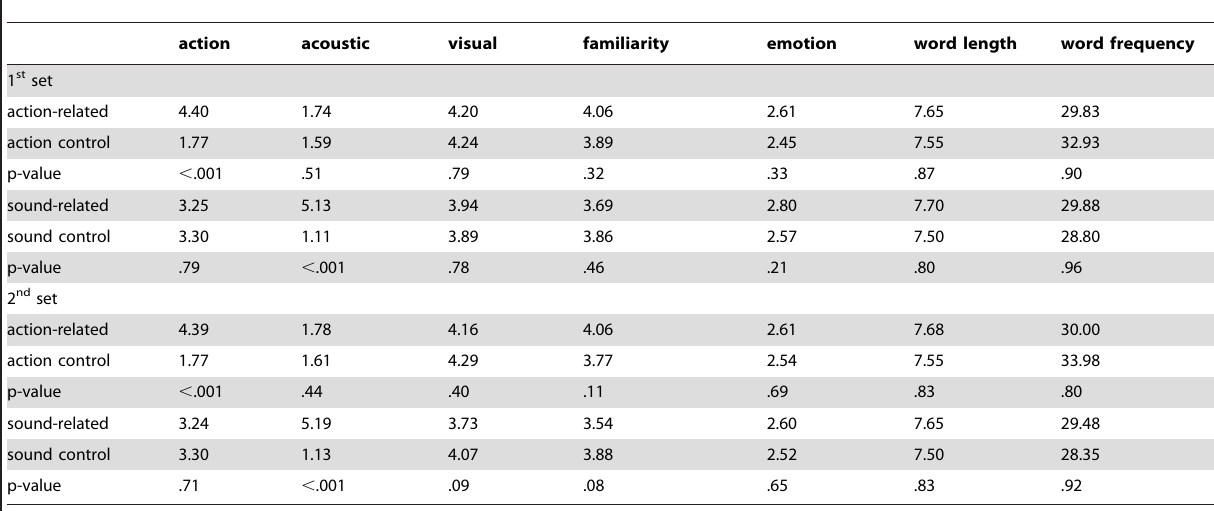
Table 1. Conceptual and linguistic variables for the critical word sets referring to action- and sound-related concepts and the corresponding control word sets as well as p-values of two-tailed